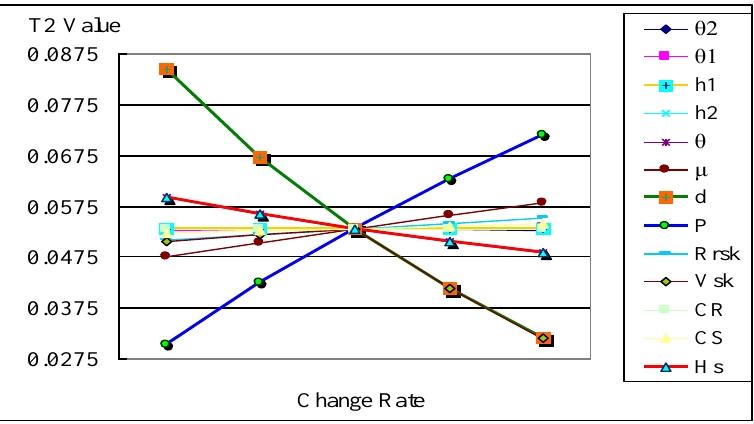
Figure 5. Sensitivity analysis for T 2 when input parameters change.